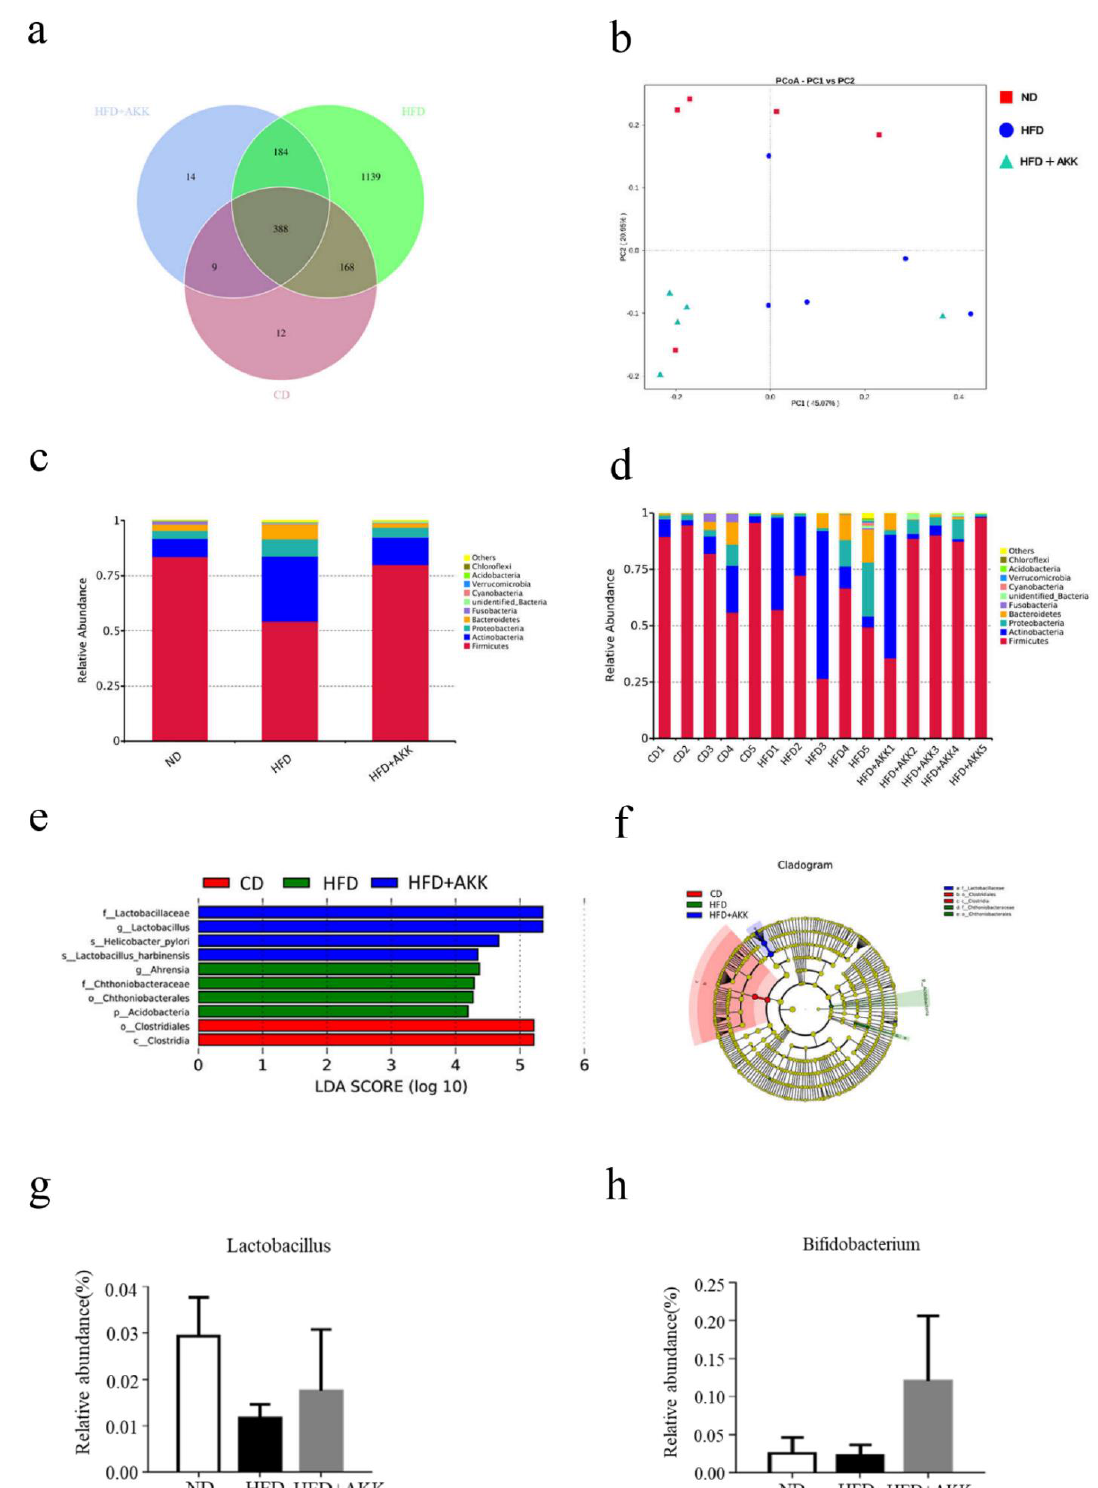
Figure 4. A. muciniphila modulated the gut microbiota in HFD-fed beagles. ( a ) Venn diagrams of the gut microbiota, ( b ) principal co-ordinates analysis, ( c ) microbial composition at the phylum level (top 10) of different groups, ( d ) microbial composition at the phylum level (top 10) of different samples, ( e ) linear discriminant analysis (LDA) score (log 10), ( f ) cladogram, ( g , h ) abundance of Lactobacillus and Bifidobacterium ,